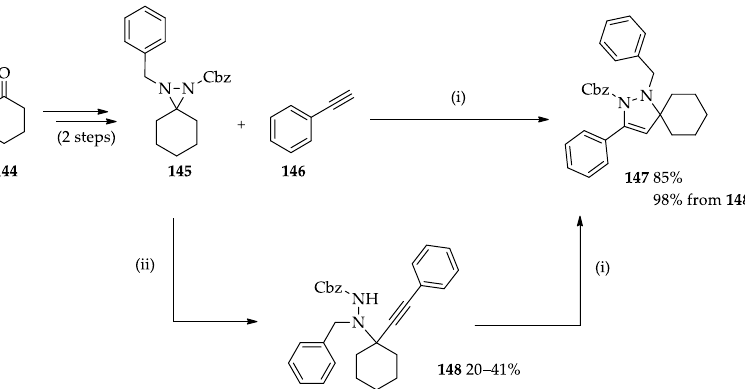
Figure 18. Metal-catalyzed formation of 3-pyrazolines 147 through cycloaddition of diaziridine 145 to alkynes 146 . Conditions: (i) 10 mol % Ph 3 AuNTf 2 , toluene, rt or 70 °C, 12 h or 18 h; (ii) 10 mol % AgOTf or AuCl 3 or Zn(OTf) 2 or Cu(OTf) 2 , toluene, 70 °C, 18 h; Cbz = carbamate group. The [3+3]-annulation of bicyclic diaziridines 149 with N -substituted aziridines 150a,b in iron salt can be processed into [1,2,4]-triazines 151a,b as a single diastereoisomer by using FeCl 3 (Scheme 11). The chelation of aziridines with FeCl 3 can lead to stereospecific ring opening using azomethine imine intermediate derived from diaziridine and the diasteroselectivity potentially obtained by the steric factors during the approaches of aziridine with the azomethine imine. Diaziridine 149 was tested using optically active aziridine 150b , demonstrating the stereoselectivity of this typical iron-catalyzed reaction [100]. The one-pot reaction of bicyclic diaziridines 152 and (2-bromo-2-nitrovinyl)arenes 153 resulting in bicyclic cationic 154 (2,3-dihydro-1H-pyrazolo[1,2-a]pyrazol-4-ium as cation and [Ce 3+ (NO 3 ) 6 ] 3− as anion) can only be conducted under the action of ceric ammonium nitrate (CAN) and MeCN (Figure 19). CAN as the catalyst can trigger in situ diaziridine ring opening of bicyclic diaziridines or metathesis of azomethine imine, the occurrence of [3+2] cycloaddition of (2-bromo-2-nitrovinyl)arenes, followed by the aromatization of the formed pyrazolidine ring [101]. This metal catalysis of diaziridine ring opening approaches (Scheme 11 and Figure 19) provides the advantage of simplicity, and is a powerful tool for the synthesis of hydrazine bicyclic compounds.